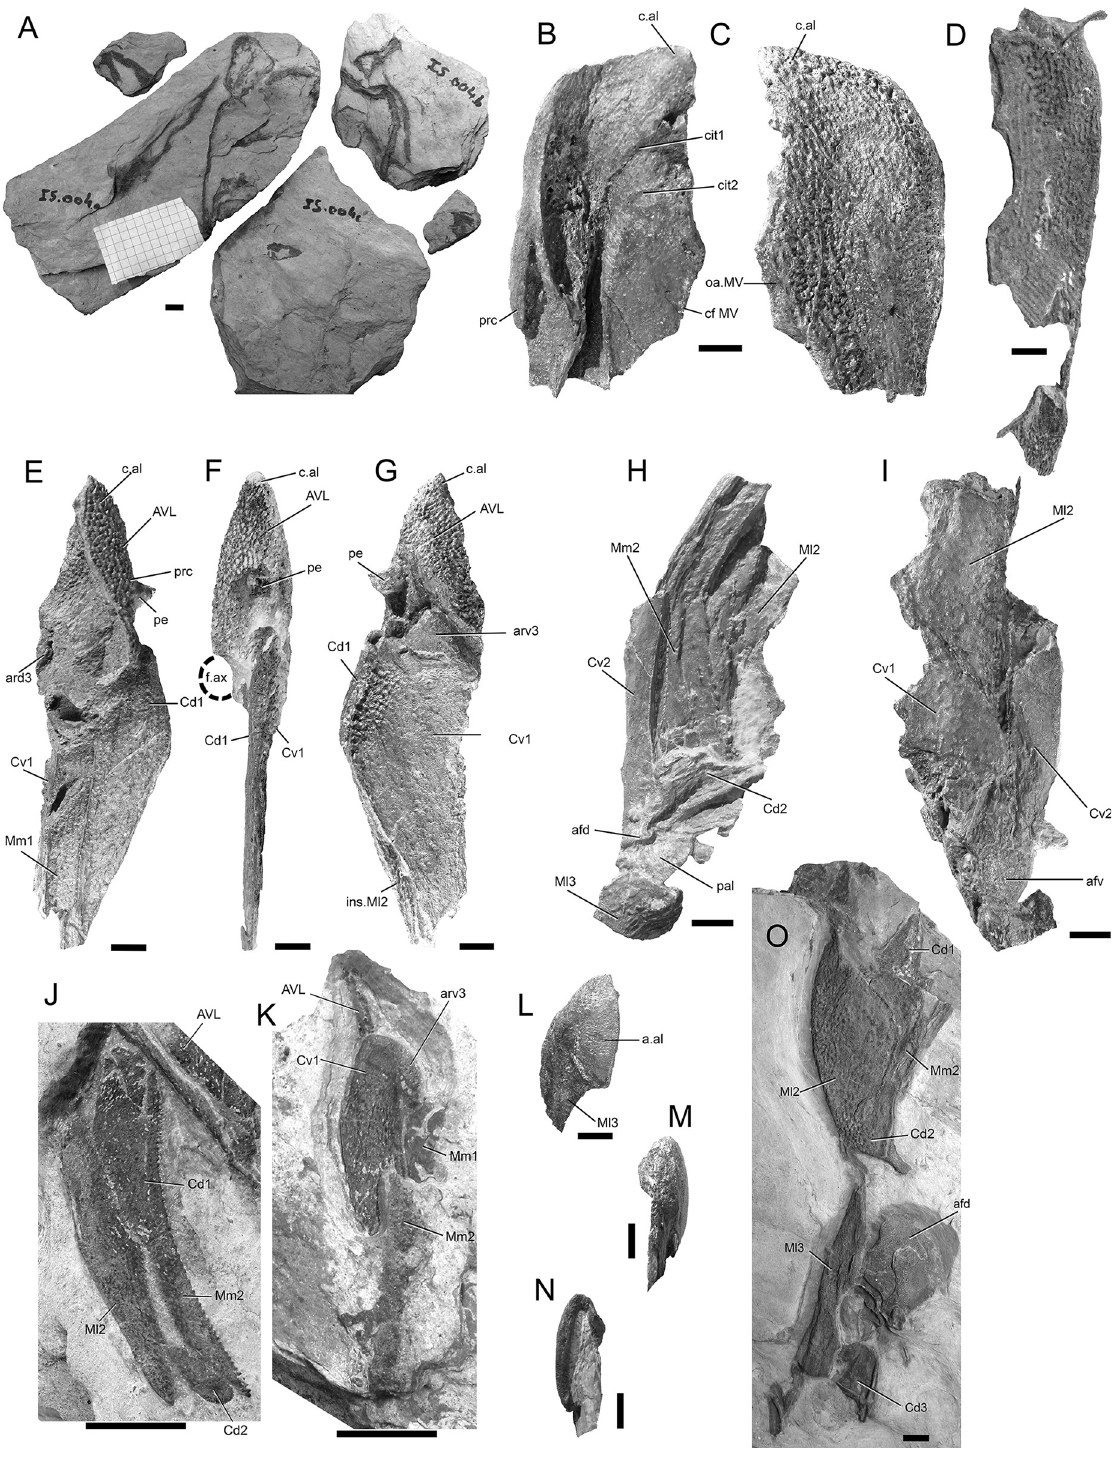
Fig 8. Bothriolepis dairbhrensis sp. nov. A. Elements of the trunk armour and the pectoral fins in dorsal view (NMING:F35217a,b,c,d). B-C. Left anterior ventrolateral plate in internal, NMING:F35218 (dorsal view, B) and in external (ventral view, C). D. Left posterior ventrolateral plate TCD 19618 FB4033 (ventral view). E-G. Incomplete right anterior ventrolateral plate and proximal segment of the fin, NMING:F35219 (E, dorsal view; F, lateral view; G, ventral view). H-I. Incomplete left proximal segment of the fin, NMING:F35220 (H, dorsal view; I, ventral view). J-K. Subcomplete proximal segments of the pectoral fins of specimen NMING:F35201 (J, left fin; K, right fin